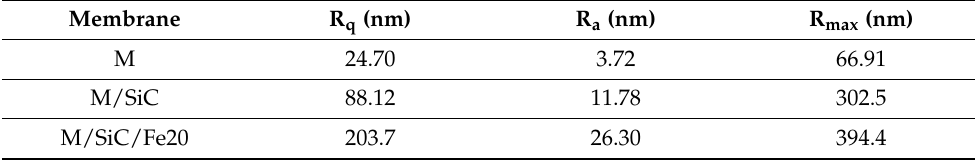
Table 4. Roughness parameters obtained from atomic force